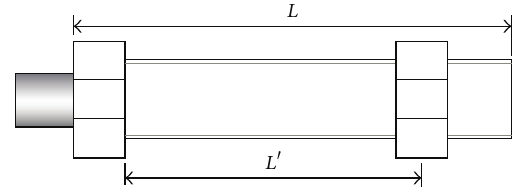
Figure 1: Bolt axial stress measurement physical model.